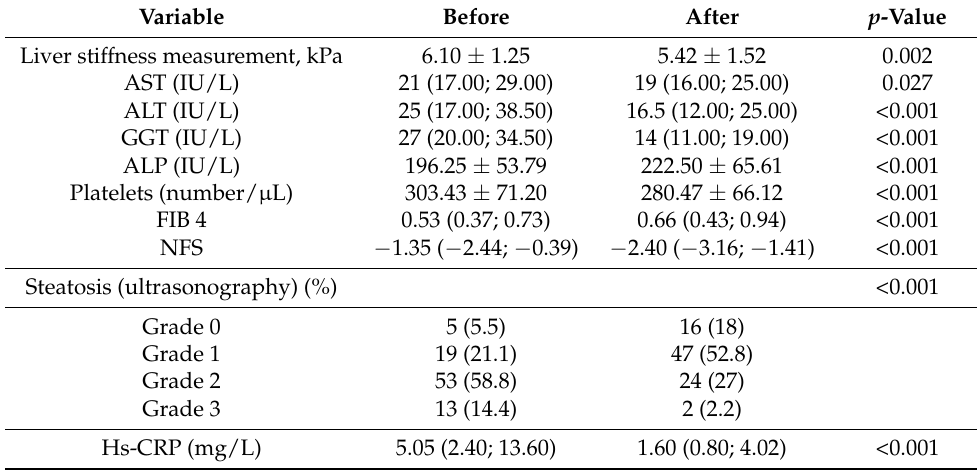
Table 2. Liver and inflammation status before and after bariatric